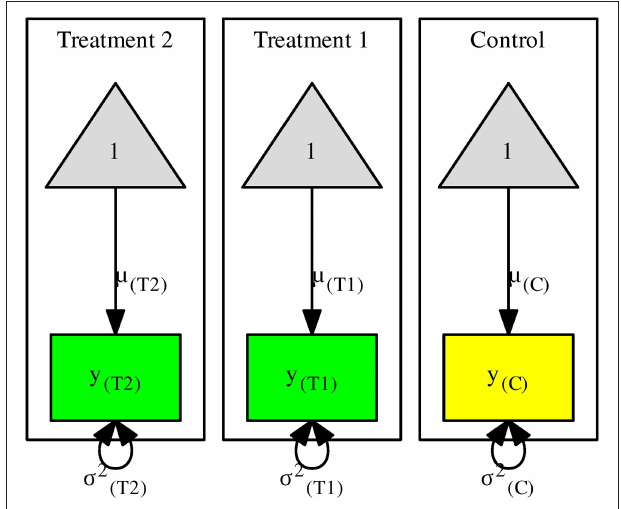
FIGURE 1 | The structural equation model for the multiple-treatment